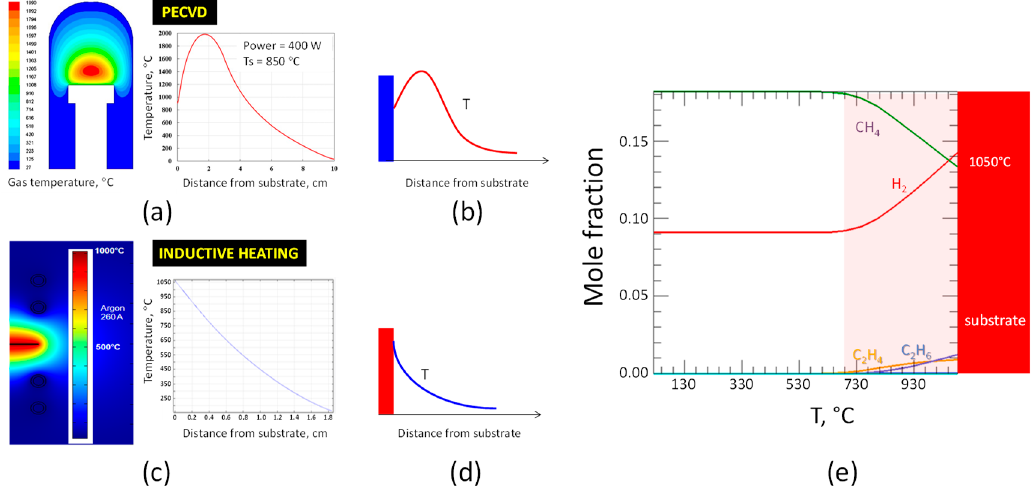
Figure 16. ( a ) Calculated temperature distribution above cobalt substrate in several PECVD conditions: 50 sccm H 2 ; 1 or 10 sccm CH 4 ; chamber pressure was maintained at 8 mbar for 300 W and 13 mbar for 400 W in order to maintain a constant plasma volume. Substrate temperature was 700 °C and 850 °C [33]; ( b ) PECVD thermal boundary layer shape; ( c ) Calculated temperature distribution above copper substrate heated at 1050 °C by inductive heating process. ( d ) Inductive heating thermal boundary layer shape. ( e ) Calculated mole fraction distribution using ANSYS Chemkin-Pro Software at pressure P=150 mbar and inlet flowrates of 400 sccm Ar, 50 sccm H 2 , and 100 sccm CH 4 . Substrate temperature was fixed at 1050 °C.